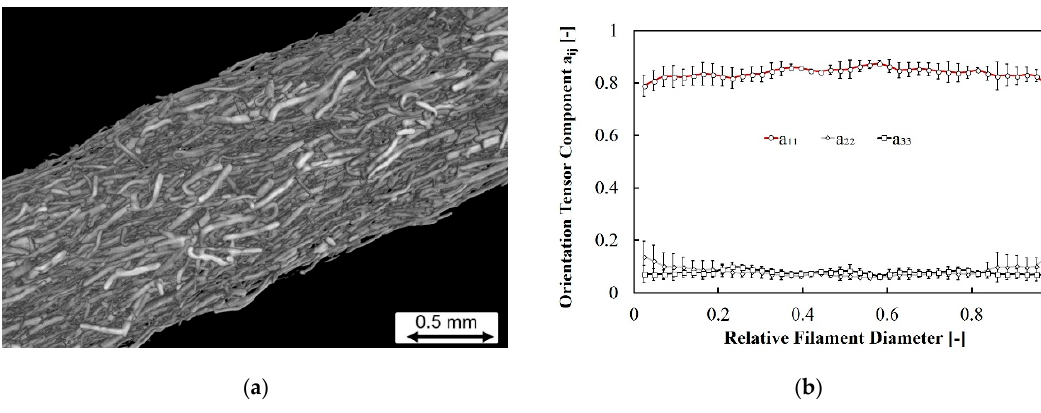
Figure 5. ( a ) 3D reconstruction of a PA6 and 20% vol copper fiber filament strand; ( b ) the measured fiber orientation distribution where a 11 is the orientation in the extrusion direction, and a 22 and a 33 are the orientation in the cross-section.